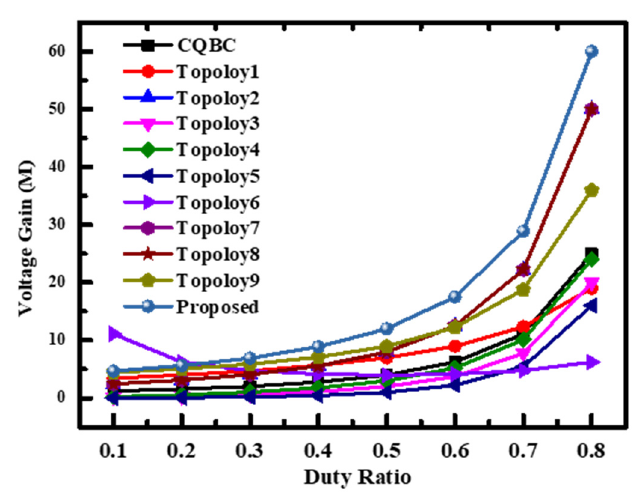
Figure 11. The voltage gain comparison plot of the recently reported proposed study.